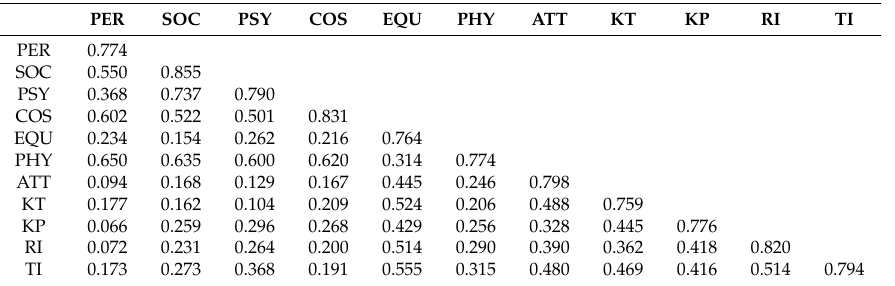
Table 5. Discriminant